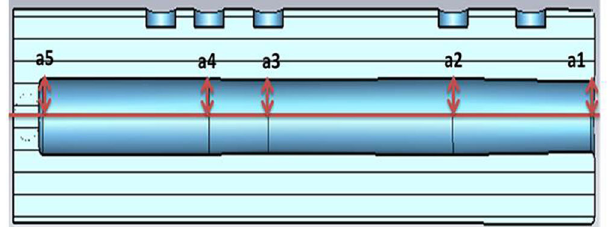
FIG. 9. Taper points chosen on the inner conductor.